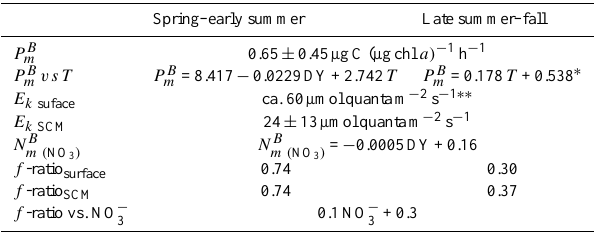
Table 2. Summary of parameterization proposed for different case